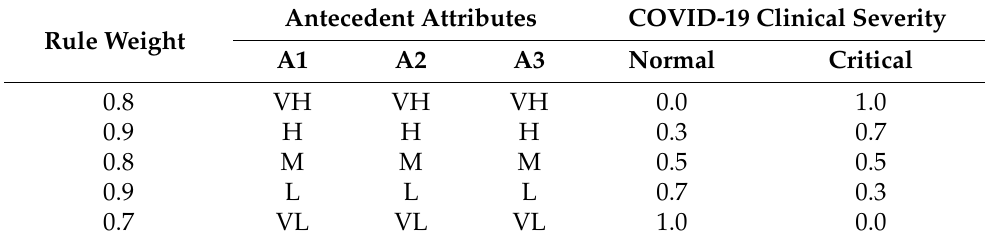
Table 8. Initial disjunctive belief rule base.